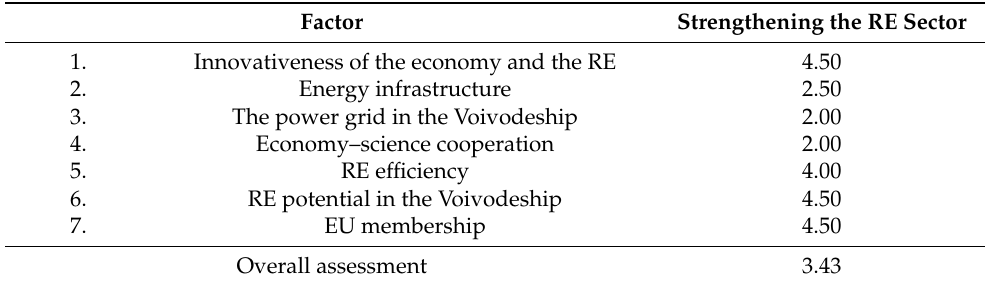
Table 4. The technological environment of RE in the Pomerania Voivodeship (author’s own